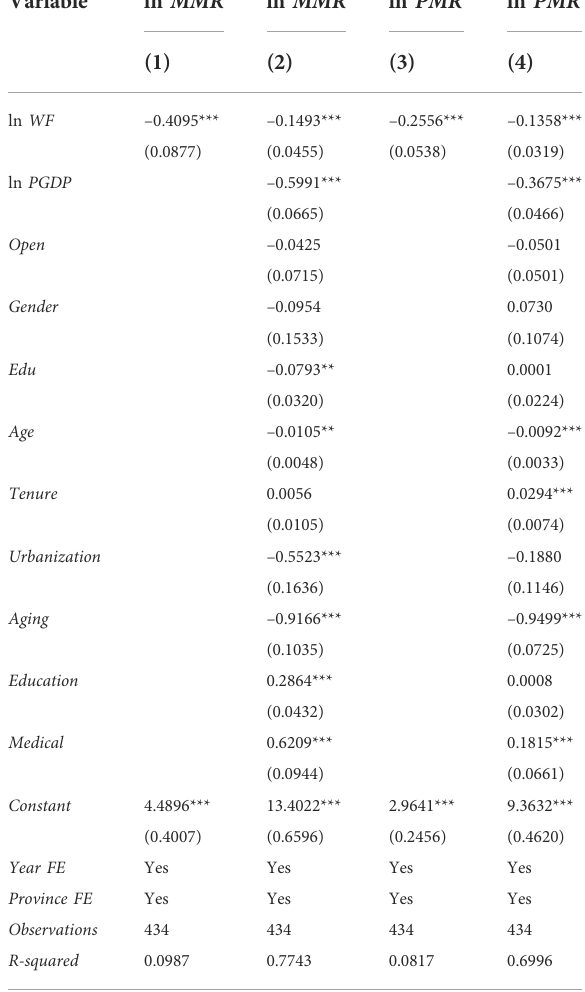
TABLE 2 Results for baseline